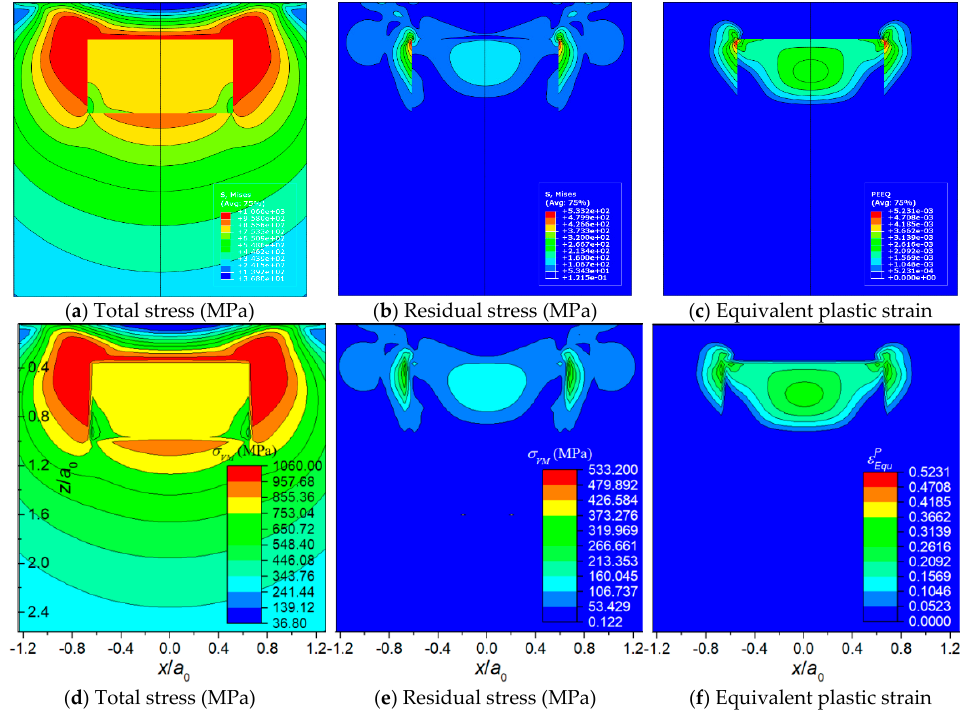
Figure 10. Case 3: The inhomogeneity is compliant and elasto-plastic. Matrix material is elasto-plastic. ( a – c ) results of FEM and ( d – f ) results of SAM.